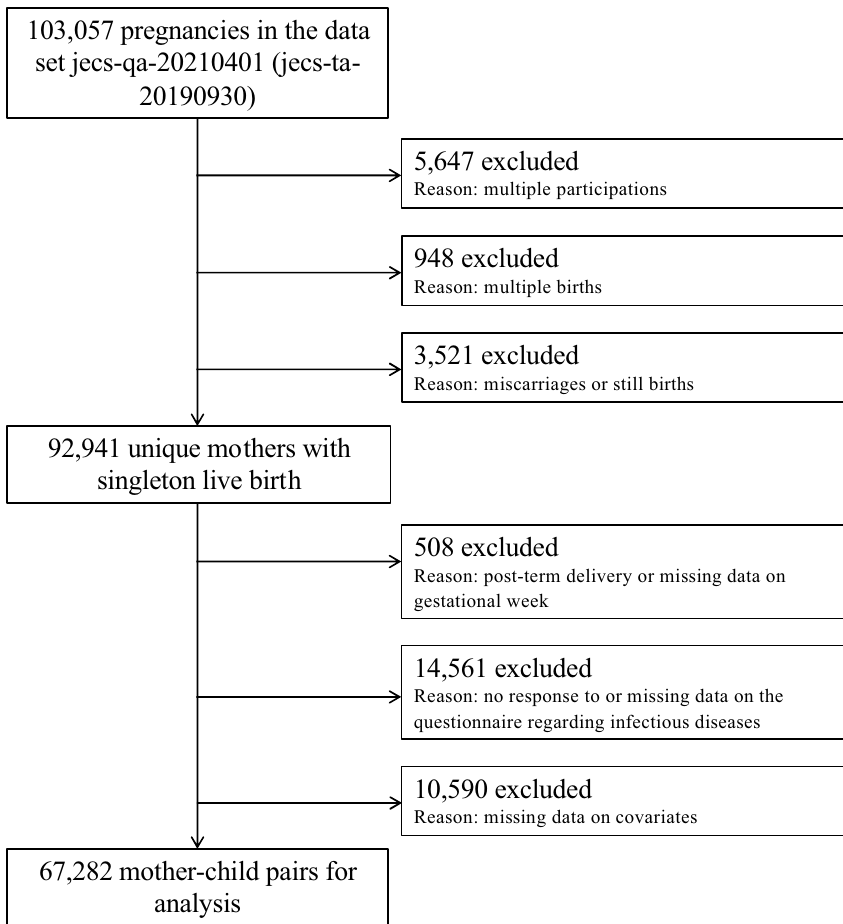
Figure 1. Participant flow diagram. Flow diagram of the recruitment and exclusion process for